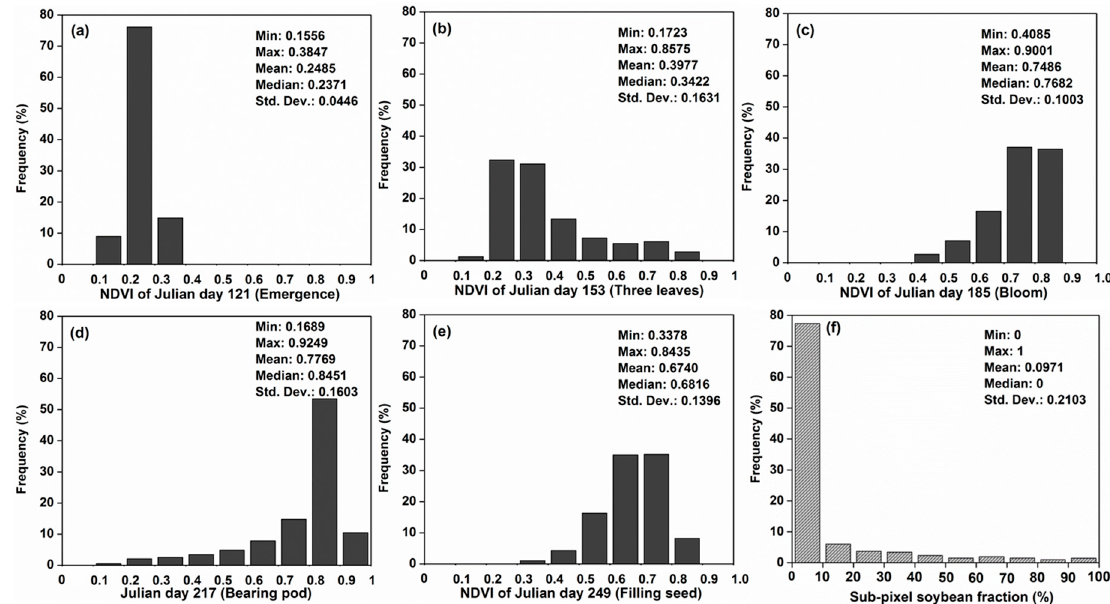
Figure 5. Histograms and descriptive statistics for the independent variables ( a – e ) and dependent variable ( f ). These five NDVI data acquired from different Julian day respond to different phenological phases and are shown as examples to represent the candidate independent variables for the 31 NDVI variables.